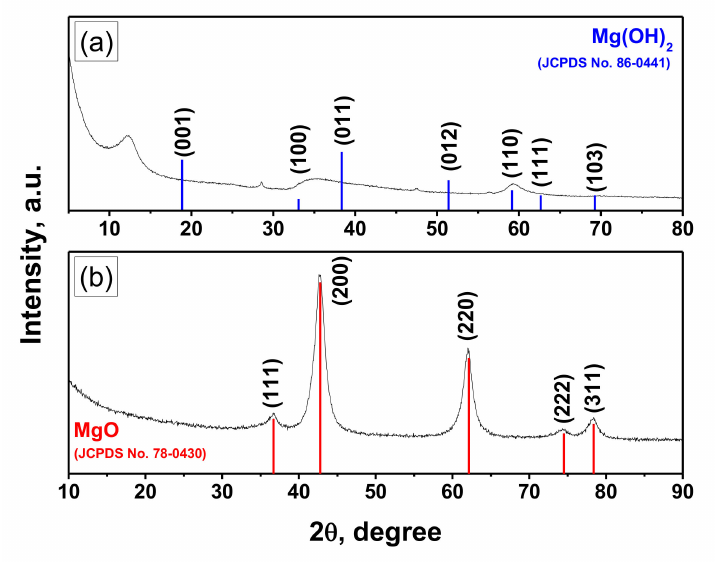
Figure 4. XRD pattern of the sol-gel prepared Ni-Mo-Mg-OH ( a ) and Ni-Mo-Mg-O ( b )